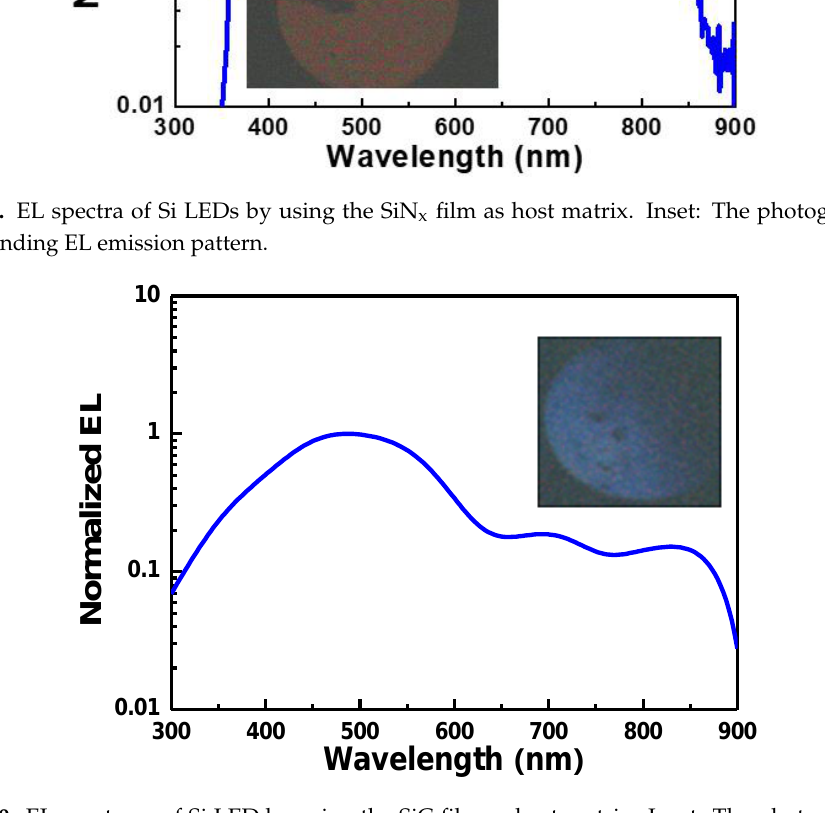
Figure 10. EL spectrum of Si LED by using the SiC film as host matrix. Inset: The photographs of corresponding EL emission patterns.